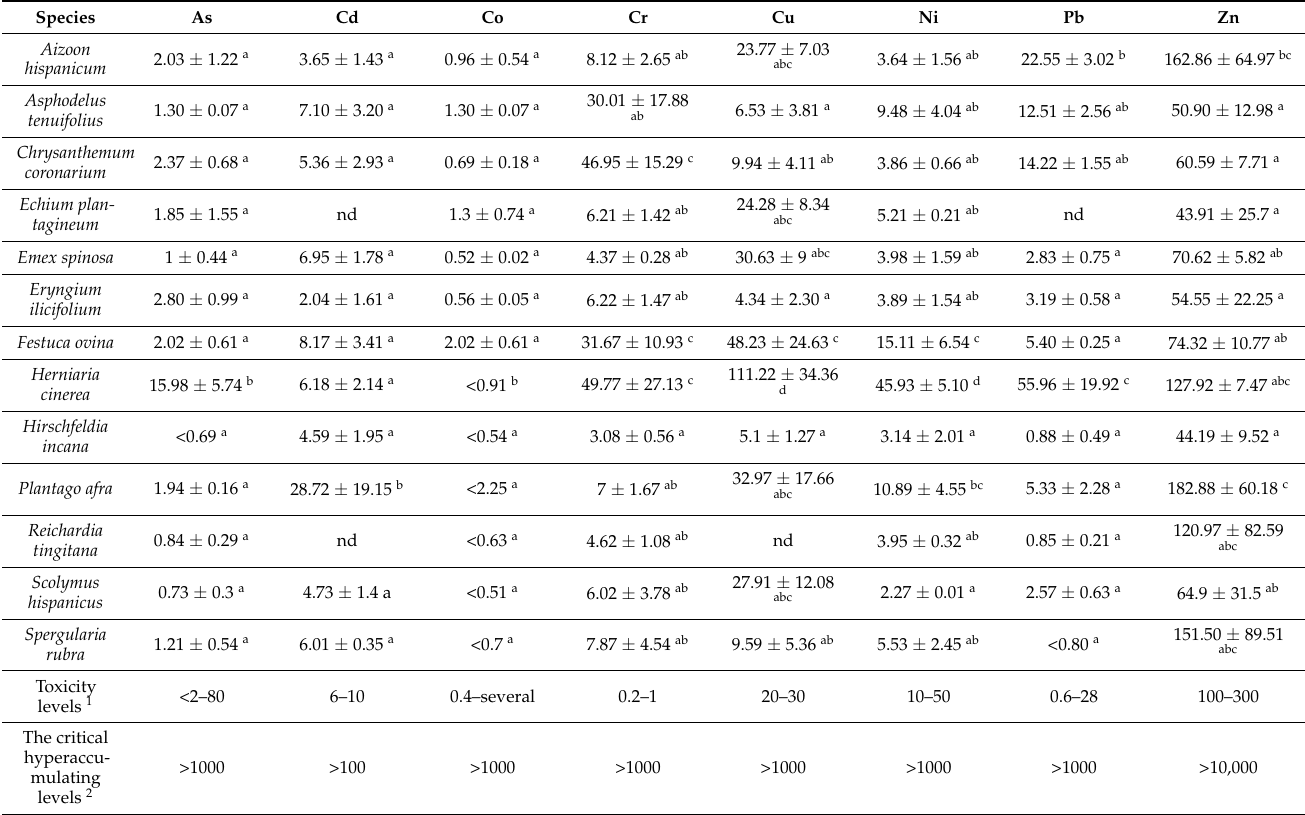
Table 3. Trace metals concentration in roots (mg/kg dry weight) of species growing in phosphate wastes cover at Kettara abandoned mine (each value represents the mean ± standard deviation of at least 3